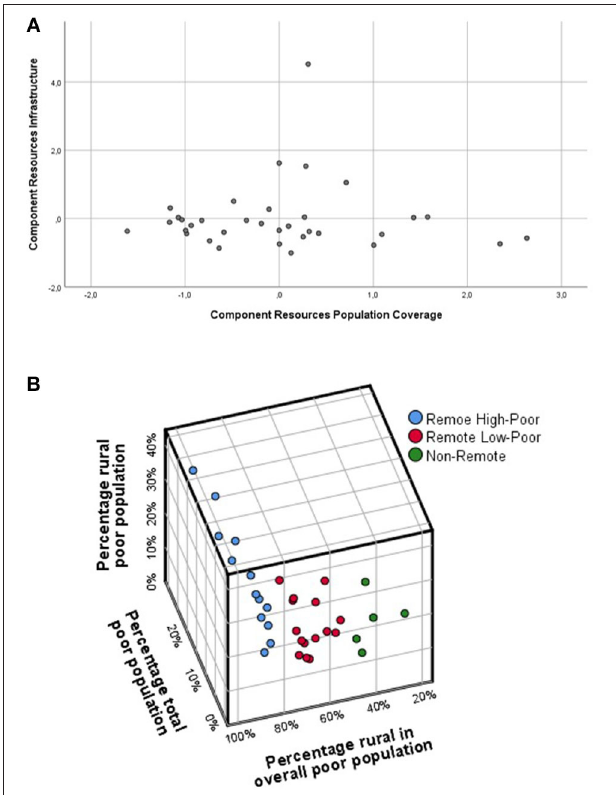
FIGURE 1 | (A) Principal component analysis (PCA) for the HRH and infrastructure availability in the provinces. The factorial load for the obtained factors, “population coverage” and “infrastructure,” is shown. DKI Jakarta is included but not considered for subsequent analysis due to its very different characteristics. (B) Grouping of provinces according to demographic and economic vulnerability using a ward three-cluster solution; for the avoidance of scaling effects and reduction of parameter variances, they have been further . Pstand, standardized standardized according to Pstand = Pprov − mean ( Pallprov ) STD ( Pallprov ) parameter per capita in each province; Pprov, parameter in the single province; Pallprov, mean and SD for the parameter of all